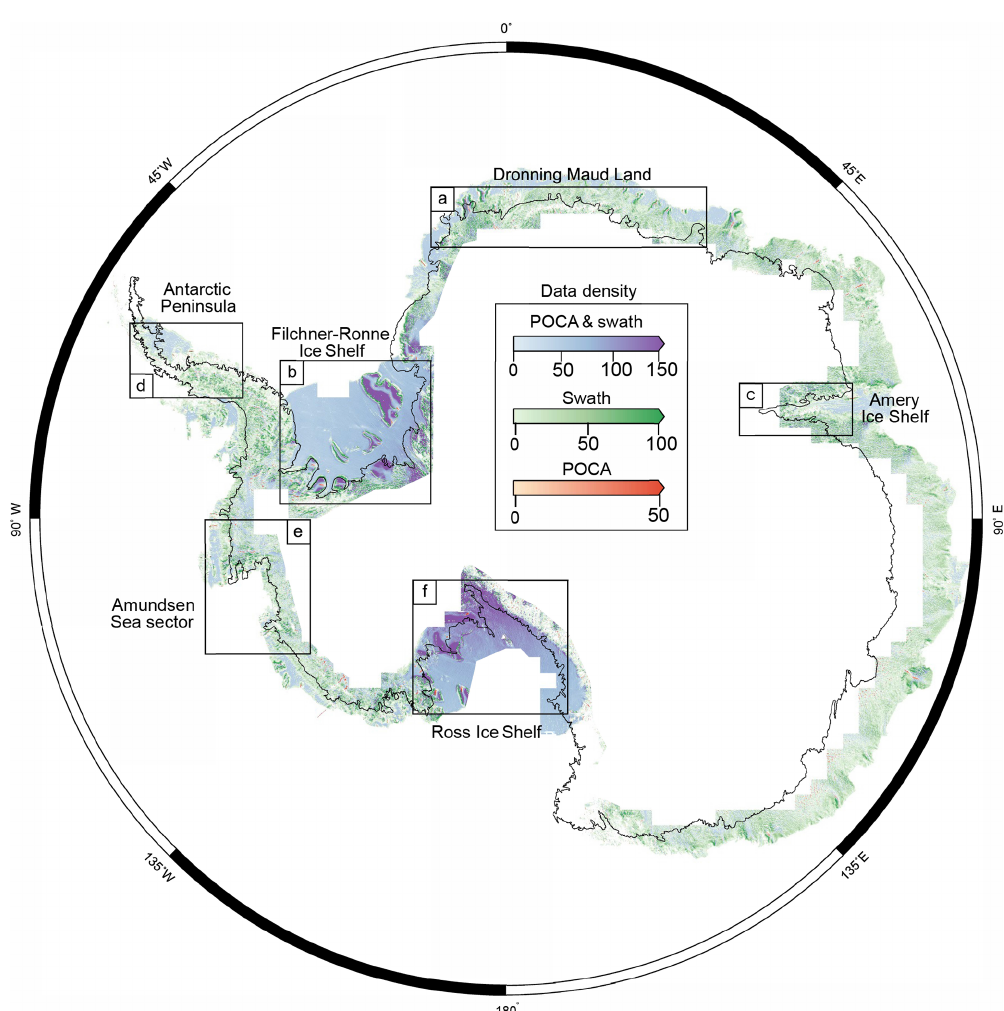
Figure 1. Data coverage plot for POCA (point of closest approach) and swath data. Red, green and blue data points correspond to where we used POCA, swath or both to calculate the tidal amplitude, T d , respectively. The colour scales show the data density (POCA points per km). The swath data density is scaled by 150 (the average number of swath to POCA data points) to match the POCA density. The black line is a composite grounding line by Depoorter et al.